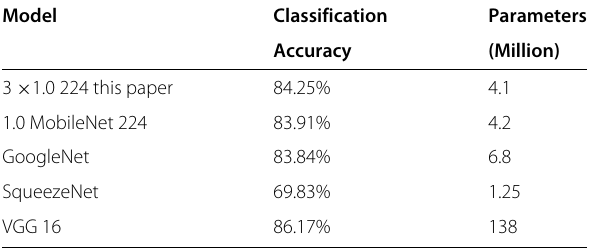
Table 3 The proposed network vs popular networks in